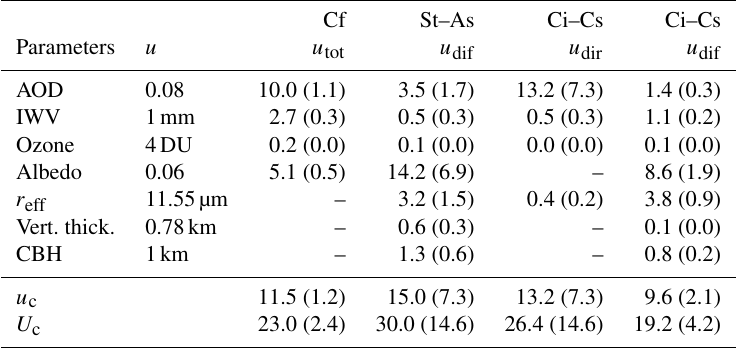
Table 2. Uncertainty analysis for the downward shortwave radiation variables (tot: total, dir: direct, dif: diffuse) under different cloud conditions in absolute (Wm − 2 ) and relative (%) numbers (in brackets). Cf: cloud-free, St–As: stratus–altostratus, Ci–Cs: cirrus–cirrostratus, u : standard uncertainty of the variables, u xxx : u multiplied by the sensitivity value, u c : combined standard uncertainty, and U c : expanded combined uncertainty (covering 95% of the data set). The sensitivities were estimated with assumed COT input values of 38 (for St–As) and 0.8 (for Ci–Cs). Estimated irradiances to calculate the relative numbers: Cf tot: 942Wm − 2 , St–As dif: 156Wm − 2 , Ci–Cs dir: 202Wm − 2 ,